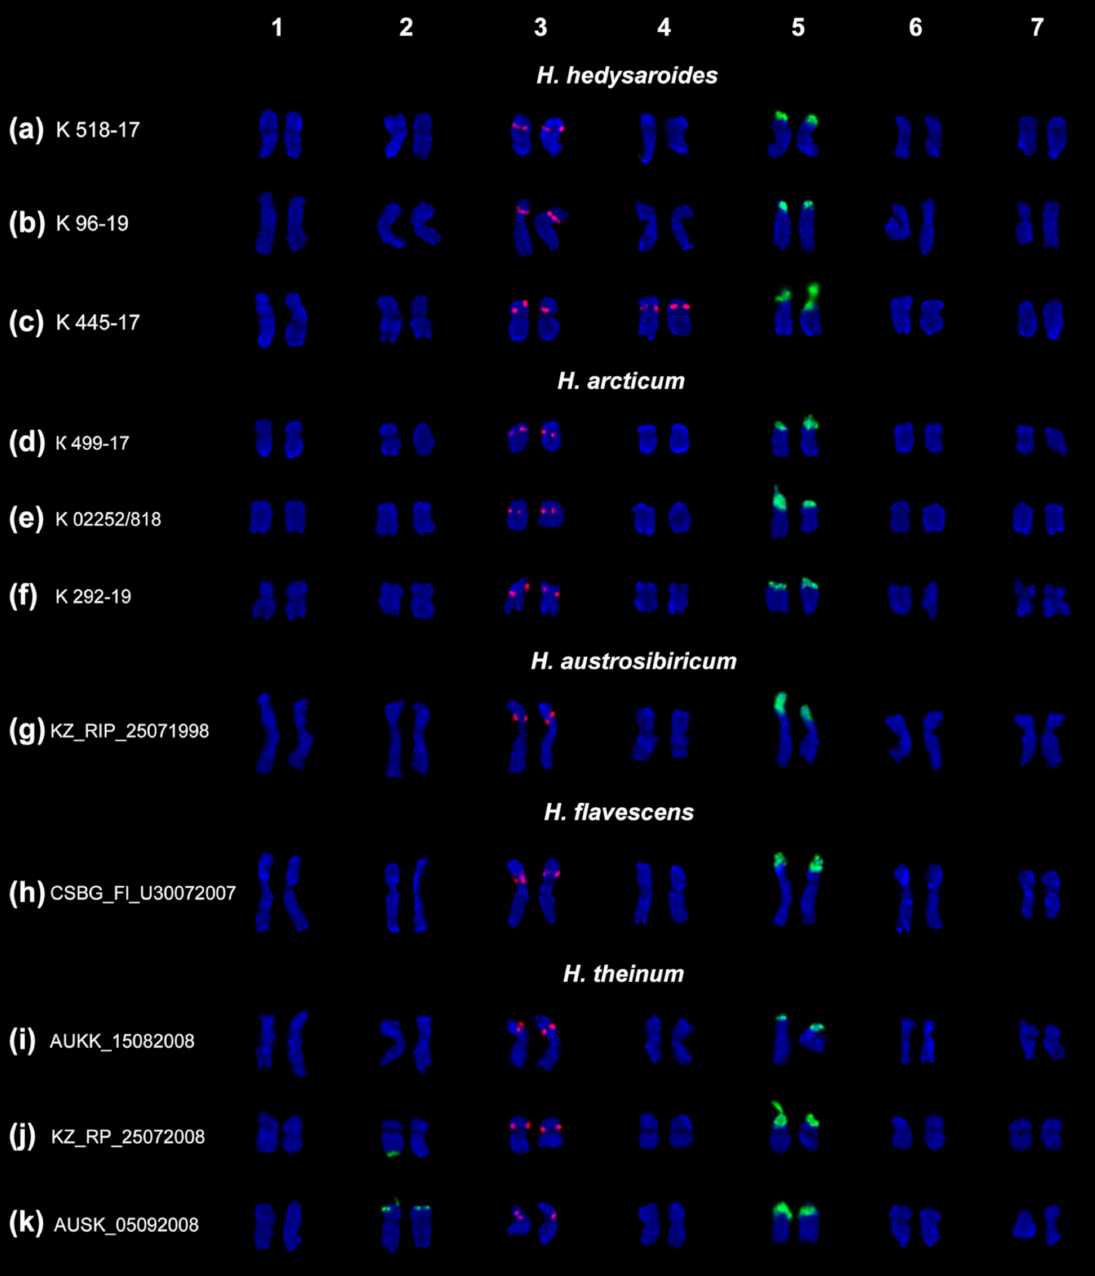
Figure 4. Karyotypes of the studied accessions of H. hedysaroides ( a – c ), H. arcticum ( d – f ), H. austrosibiricum ( g ), H. flavescens ( h ) and H. theinum ( i – k ). Karyograms of the metaphase plates shown in Figure 3 after FISH with 45S rDNA (green) and 5S rDNA (red). DAPI chromosome